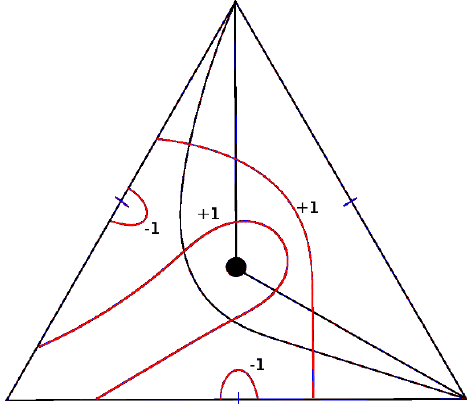
Figure 3. An example of a WKB triangulation of the once-punctured triangle and a lamination, corresponding to the line defect B 2 in the ( A 1 ; D 3 ) Argyres-Douglas theory. (cid:15) the lamination representing the line defect, (cid:15) the WKB triangulation determined by the chosen point of the Coulomb branch and phase of the line